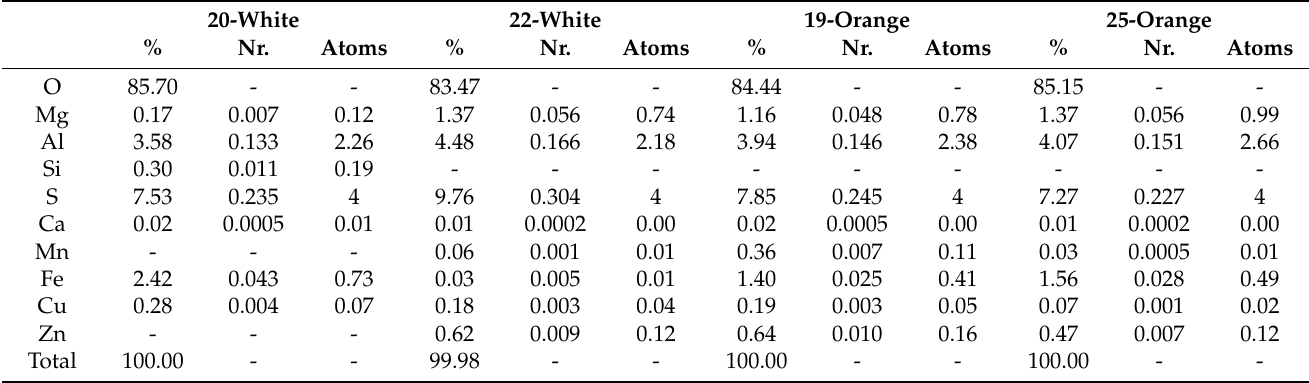
Table 4. Chemical characterisation of the Algares samples obtained through SEM-EDS analyses.